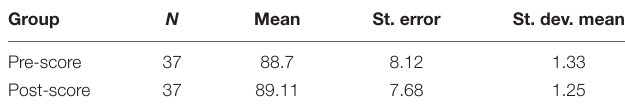
TABLE 7 | Pair sample statistics (control class).